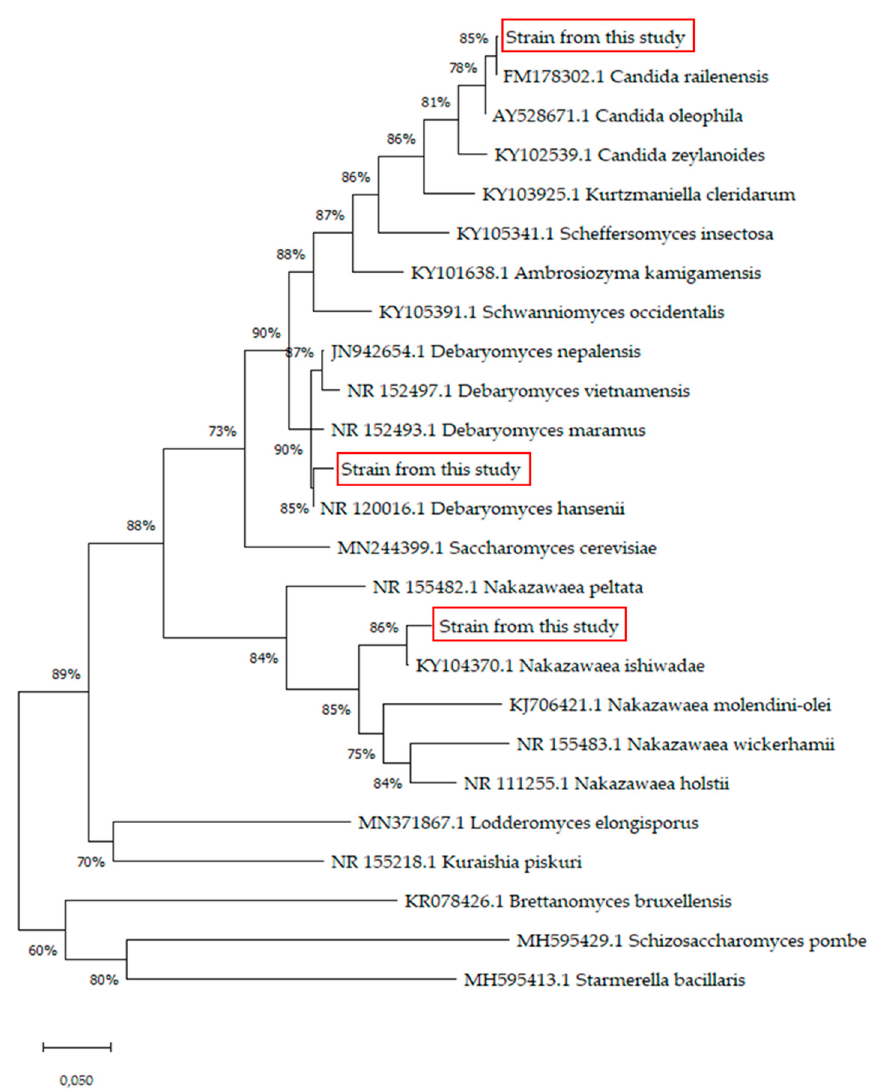
Figure 1 . Maximum likelihood analysis showing the placement of the non- Saccharomyces species used in the study among common wine and closely related yeasts, including using their ITS1–5.8S–ITS2 region. The dendrogram was based on the general time reversible model (GTR + G + I) as determined with MEGA 5.2 [14,20]. Bootstrap percentages from a 1000 bootstrap replicates are shown. Bar, 5% sequence divergence.